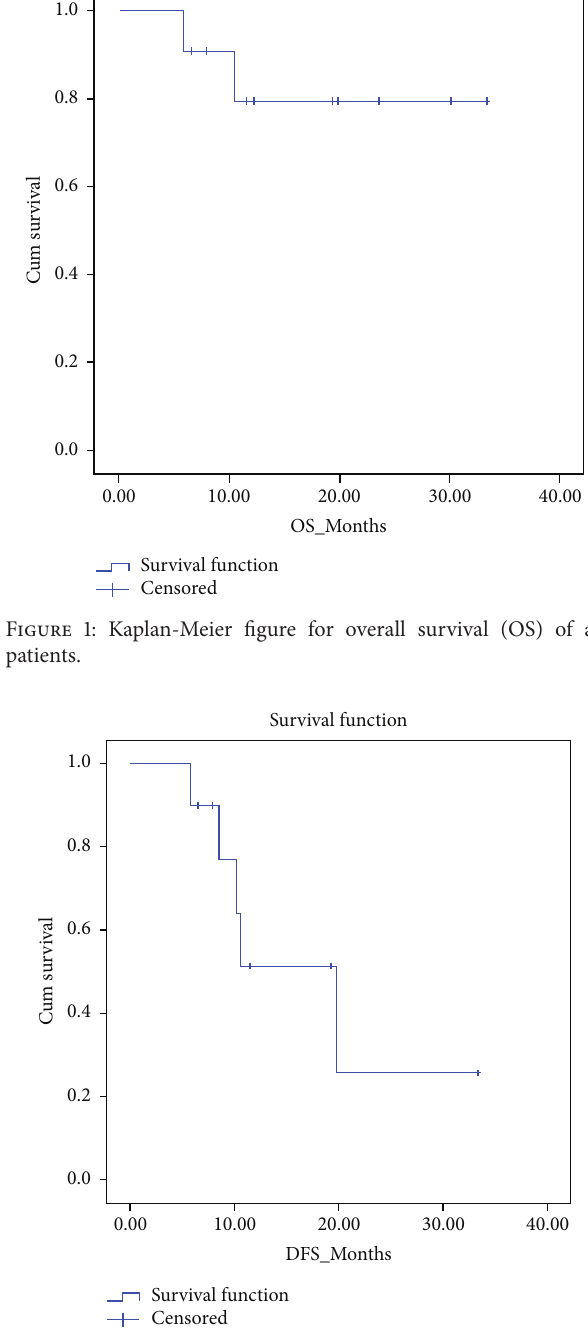
Figure 2: Kaplan-Meier curve for disease-free survival (DFS) of all